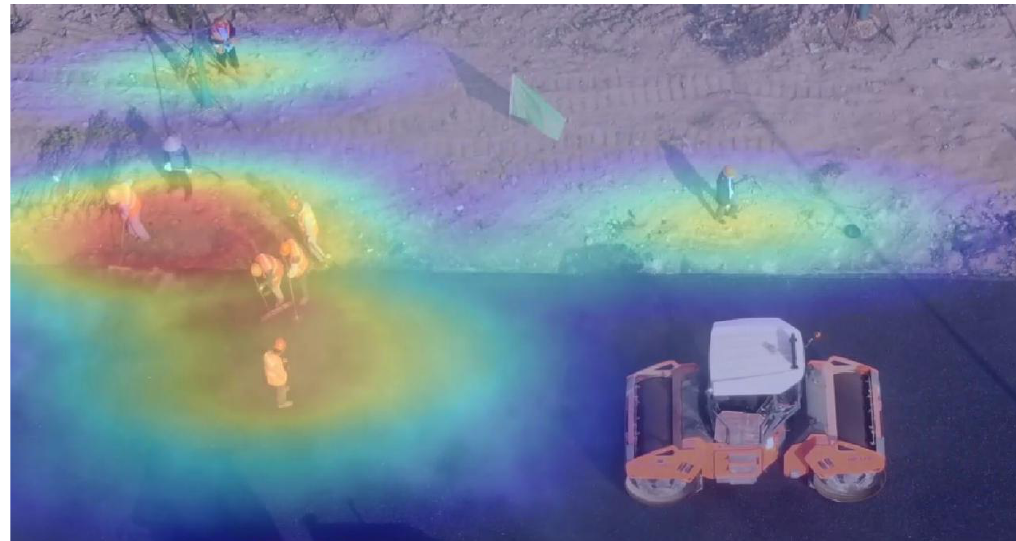
Figure 9. Tracking heat map of constructors.